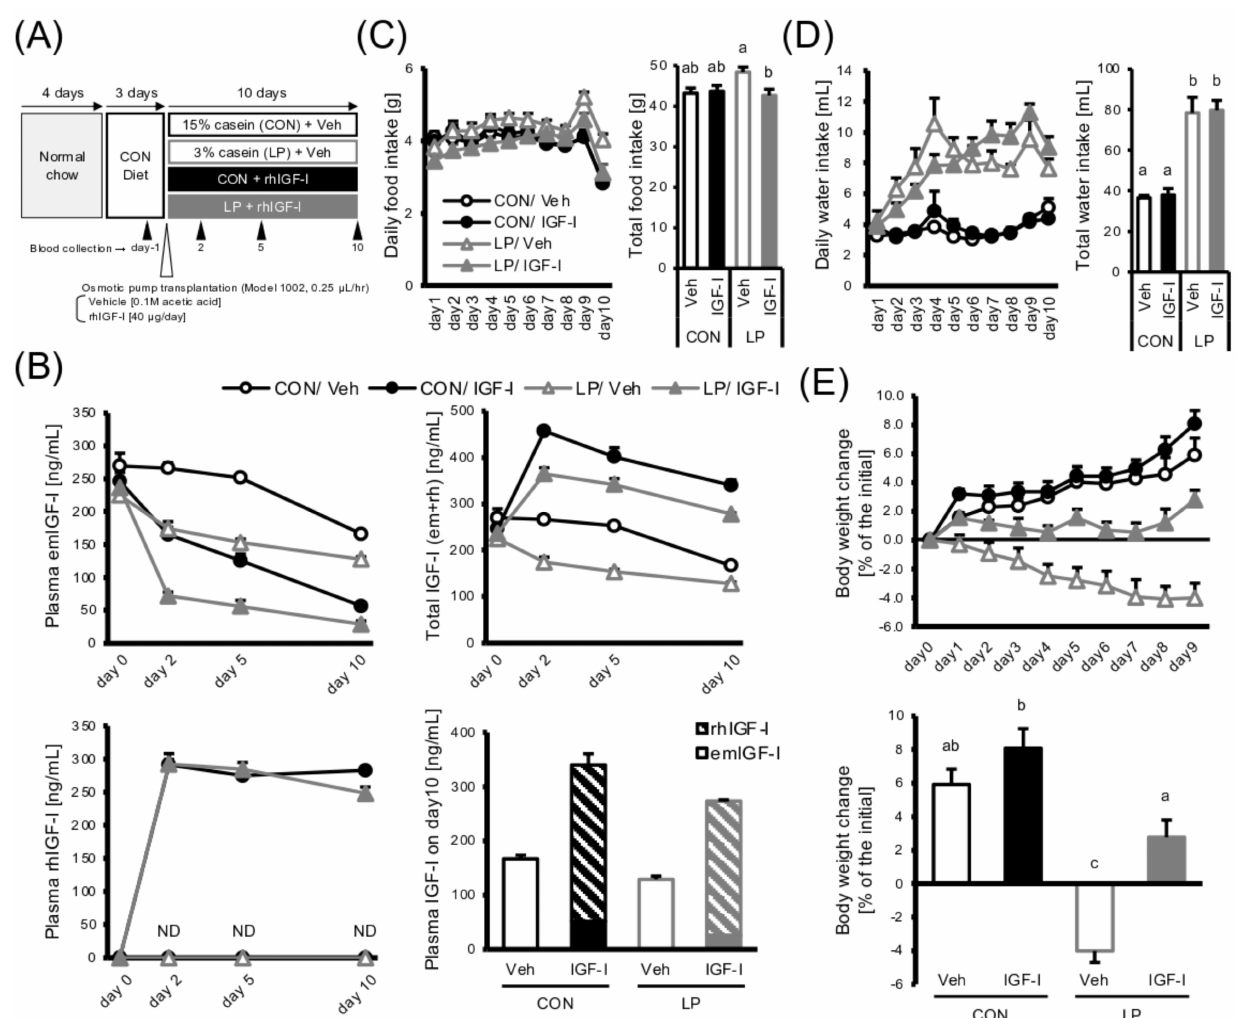
Figure 2. IGF–I infusion restores growth retardation caused by dietary amino acid deficiency. ( A ) Schematic of the experimental design. Seven-week-old male C57BL/6 mice were fed stan- dard chow for 4 days, followed by a 15% casein experimental diet (CON) for 3 days, for training. Then, osmotic pumps carrying either rhIGF–I or vehicle were transplanted into the mice, and they were fed either a CON diet or 3% casein low–protein diet (LP) for another 10 days; ( B ) Plasma IGF–I concentration was measured on days 0, 2, 5, and 10. Endogenous emIGF–I ( upper left ) and exogenous rhIGF–I ( lower left ) of each sample were separately analyzed, and total plasma IGF–I was calculated as the sum of both ( upper right ). The total plasma IGF–I concentration on the last day is also indicated by a bar graph; ( C ), Daily food intake ( left ), and total food intake during the experimen- tal period ( right ). ( D ) Daily water intake ( left ) and total water intake during the experimental period ( right ). ( E ) The bodyweight change of each mouse is indicated as a percent increase (or decrease) of the initial body weight ( upper ). The ratio of the final body weight to the initial body weight is also indicated as a bar graph ( lower ). Statistically significant differences were observed between groups with different alphabetical characters; Bar: mean ± S.E.M. ( C – E ): n = 6, Tukey–Kramer test; ( B ): n = 3–6, Tukey–Kramer test. ND means not